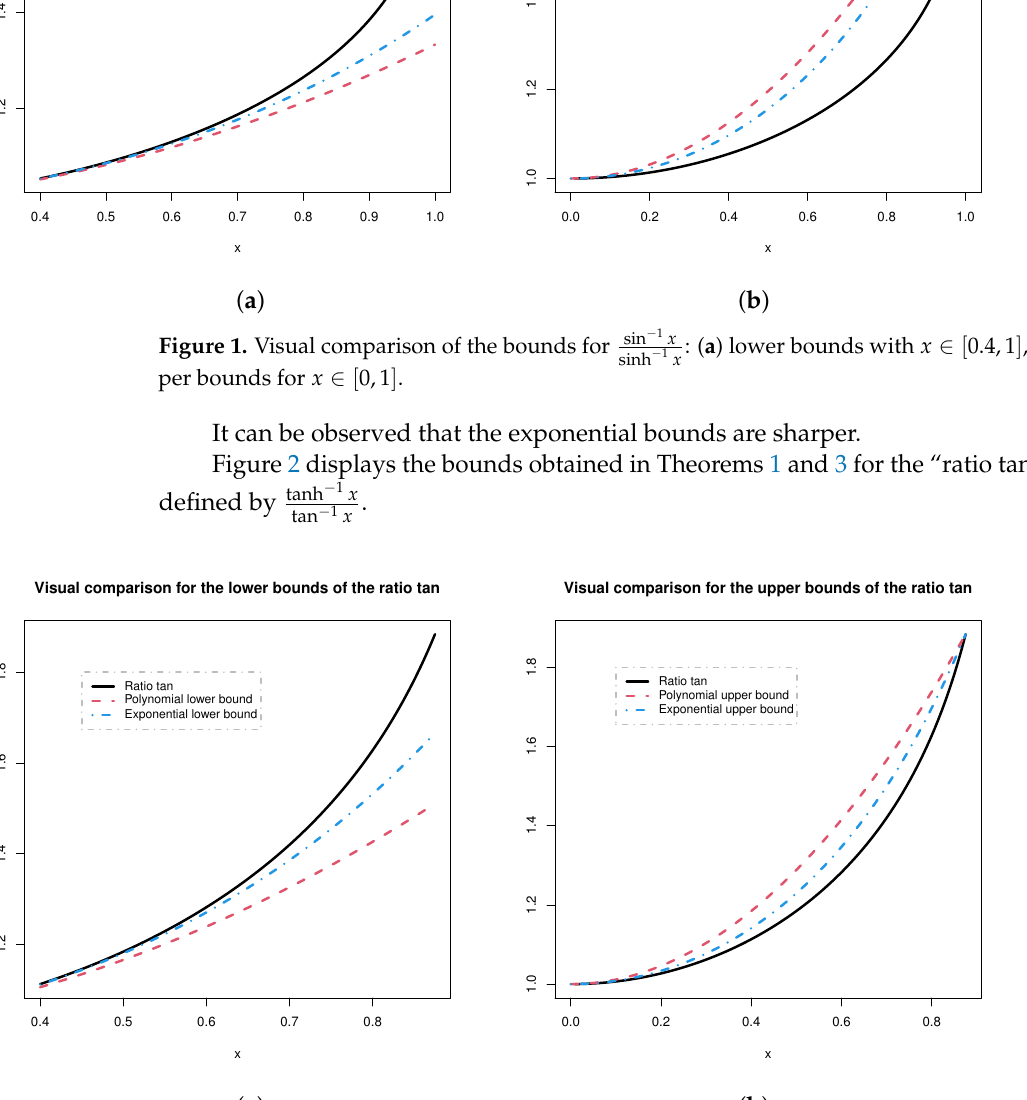
− 1 x Figure 2. Visual comparison of the bounds for tanh : ( a ) lower bounds with x ∈ [ 0.4, r ] , and ( b ) up- tan − 1 x per bounds for x ∈ [ 0, r ] , with r = 7 (arbitrarily taken into ( 0,1 ) ). 8 Again, it can be observed that the exponential bounds are